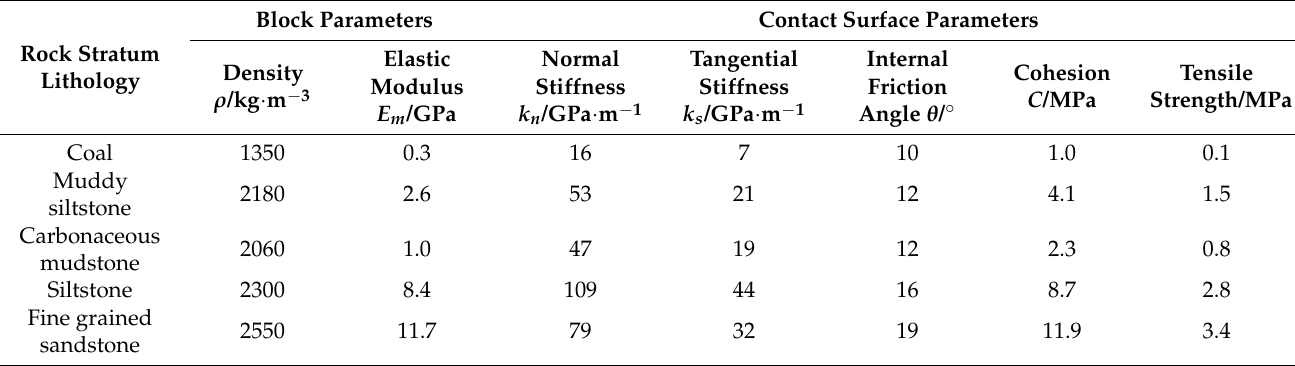
Table 2. Mechanical parameters of each rock stratum in the